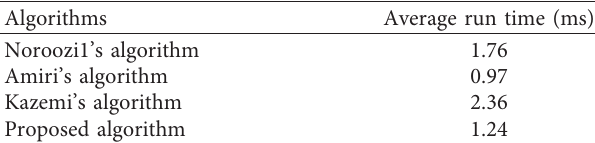
Table 2: Time cost of the